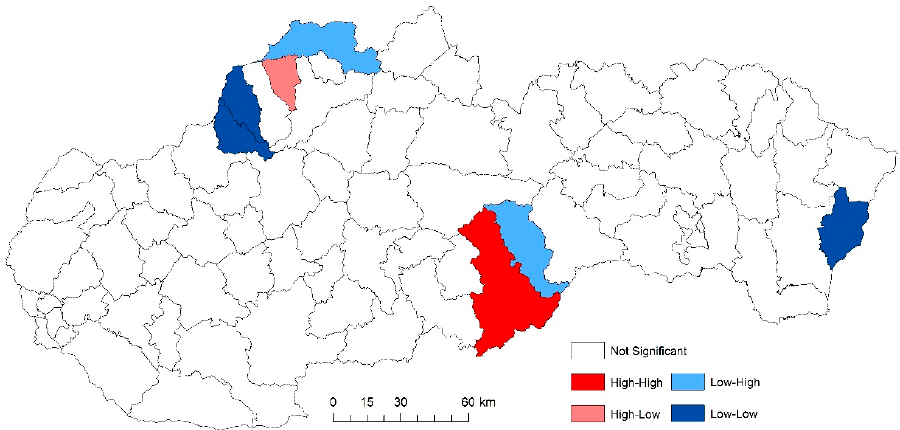
Figure 15. Standardized death rate of prostate cancer per 1000 inhabitants of European Standard Population, 2013–2018.